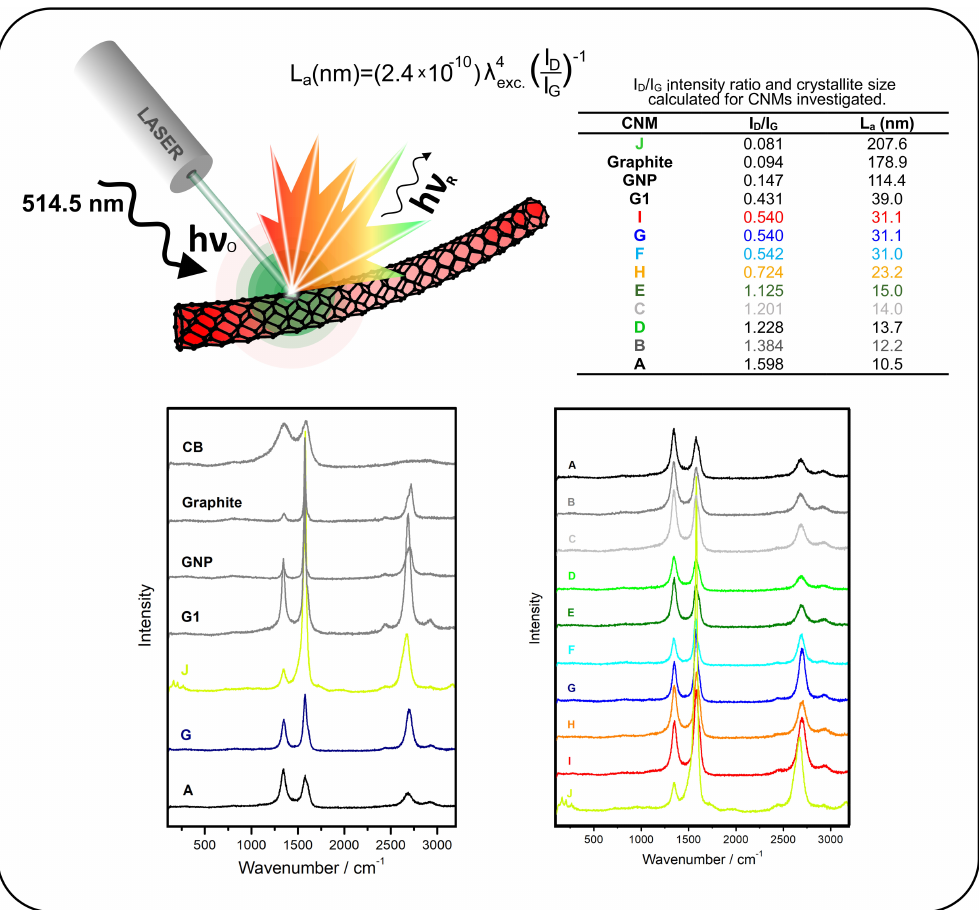
Figure 4. Comparison of Raman spectra for pure SW/DWCNTs and common MWCNTs of low purity, additional carbon black (CB) and graphene signals for reference; crystallite size L a calculated by using the equation [49] where λ is the laser line wavelength in